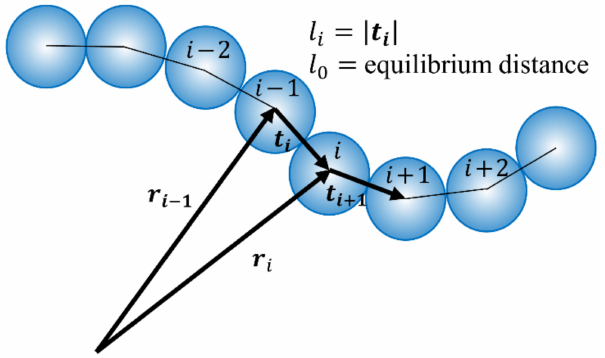
Figure 3. Schematic of worm-like chain (WLC) model used as a connected particle